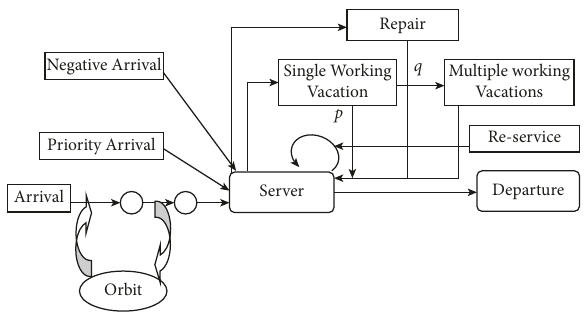
Figure 1: A priority retrial queue with the M/ G